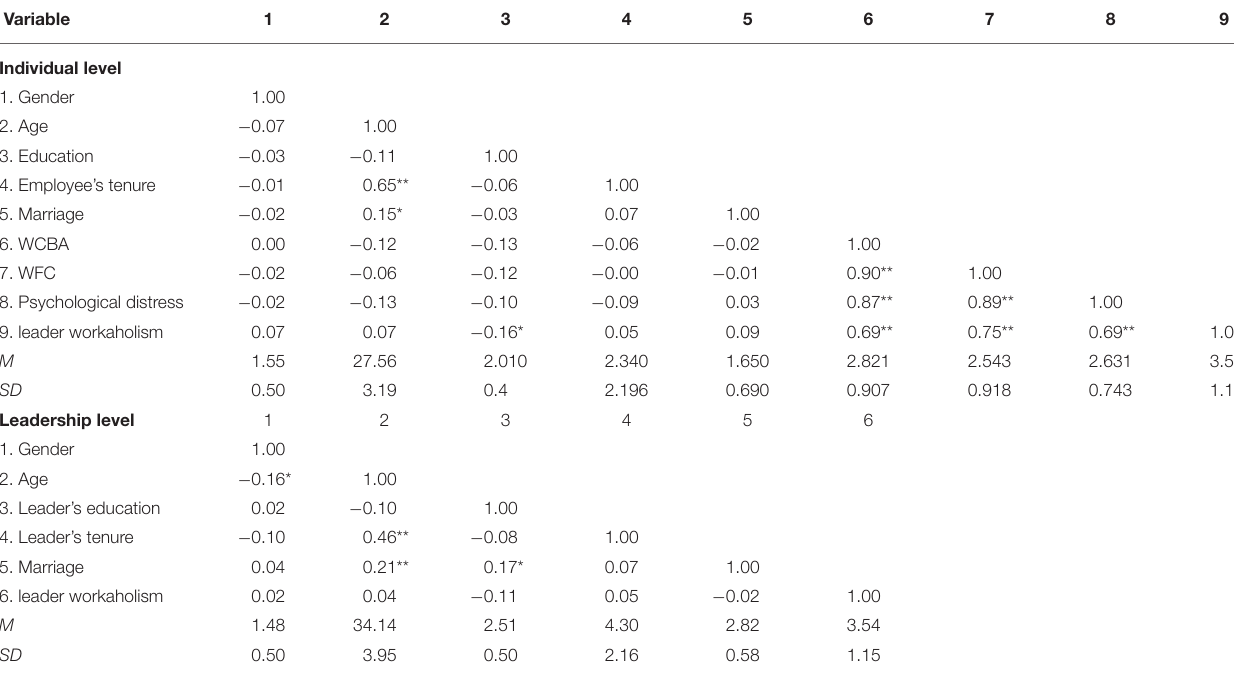
TABLE 1 | Means, standard deviations, and correlations of the research variable. Variable